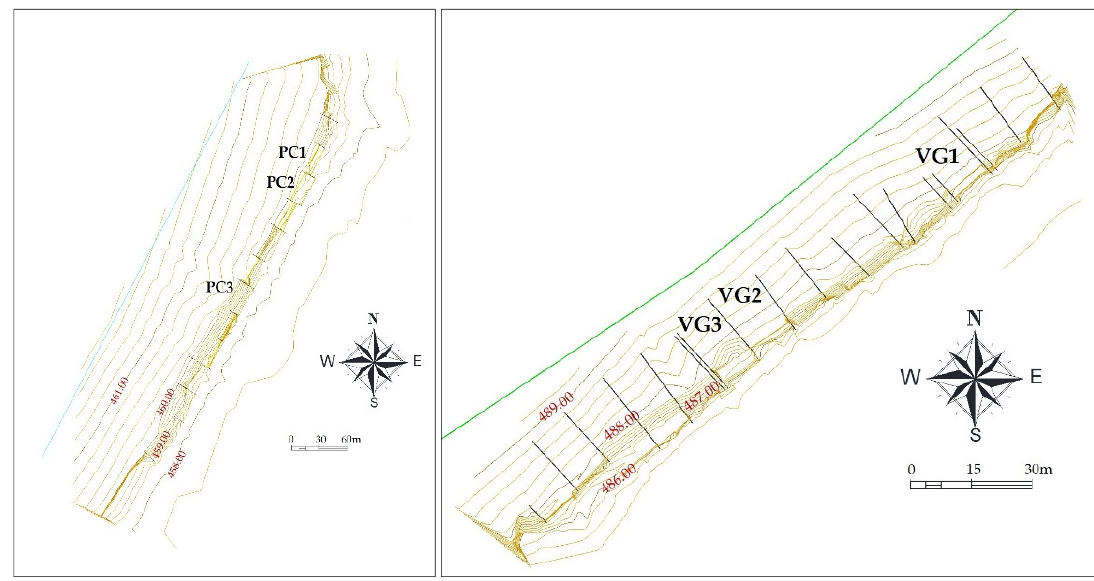
Figure 3. Identification of the sections installed in the HPP experimental units. Porto Colômbia (PC) (left panel) and Volta Grande (VG) (right panel). Table 2. Erosion control techniques evaluated and respective installation site.